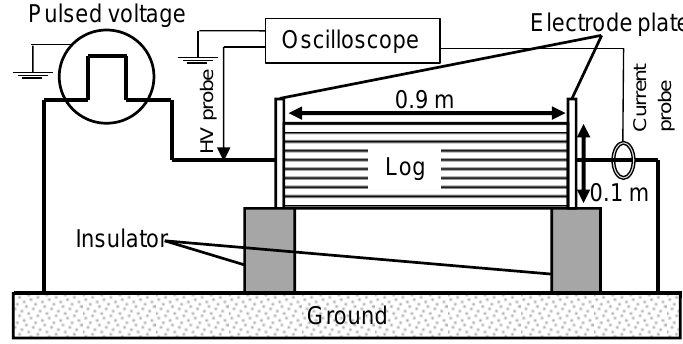
Figure 5. Experimental setup for pulsed voltage stimulation to the L. edodes logs.